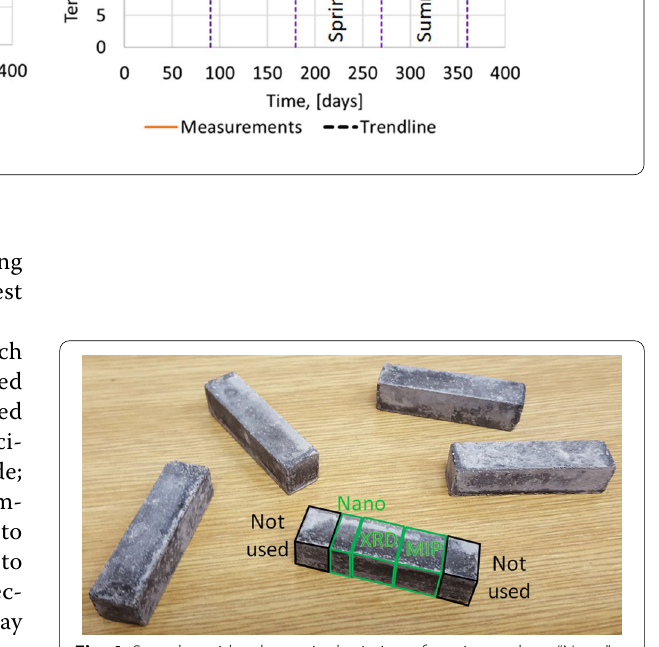
Fig. 4 Samples with schematic depiction of sections, where “Nano” stands for